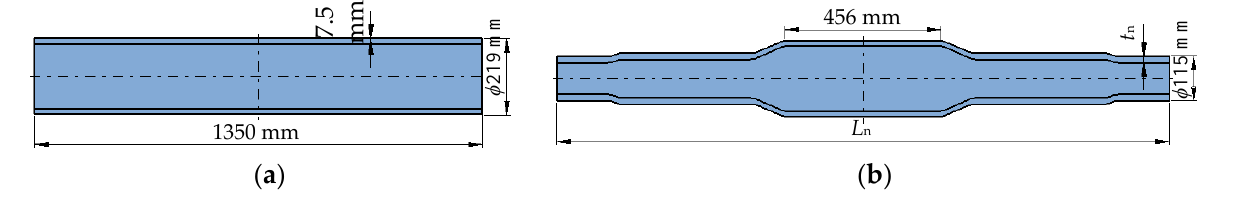
Figure 11. Process diagram of PDR. ( a ) Initial tube; ( b ) reduced tube.